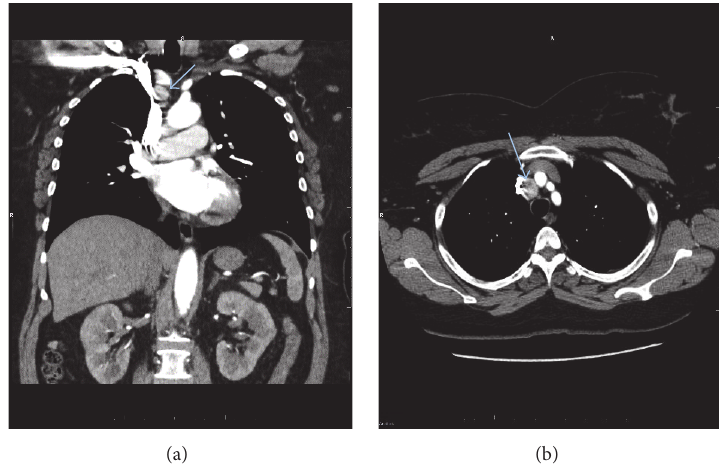
Figure 1: A right paratracheal mass in the upper mediastinum on the images of CTA from a patient presented with cough and right chest pain. A 61-year-old female presented to emergency room with cough and right chest pain. Chest CTA was performed to exclude pulmonary embolism as partof chest pain workup. One2.0 × 1.7 cm rightparatracheal mediastinal masswas visualized on theimages of CTA,as indicated by a blue arrow on coronal (a) and axial (b) view images of CTA. This right paratracheal mass appeared hyperdense or showed mild contrast enhancement relative to other small mediastinal lymph nodes.